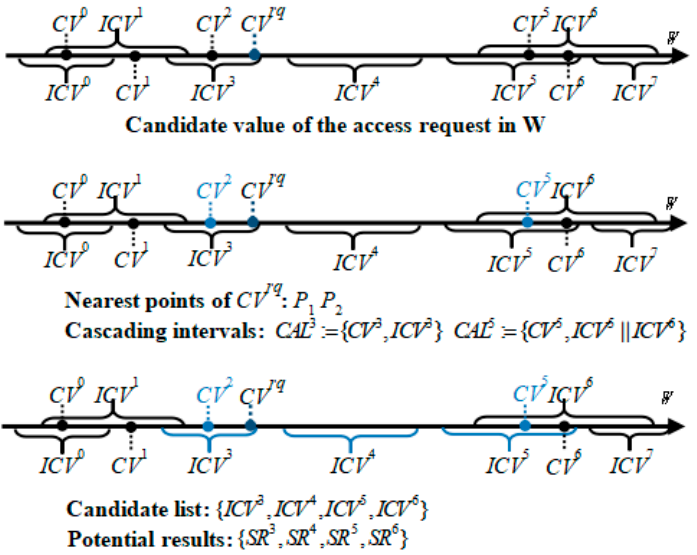
Figure 7. Brief description of implementing evaluation module using candidate lists.